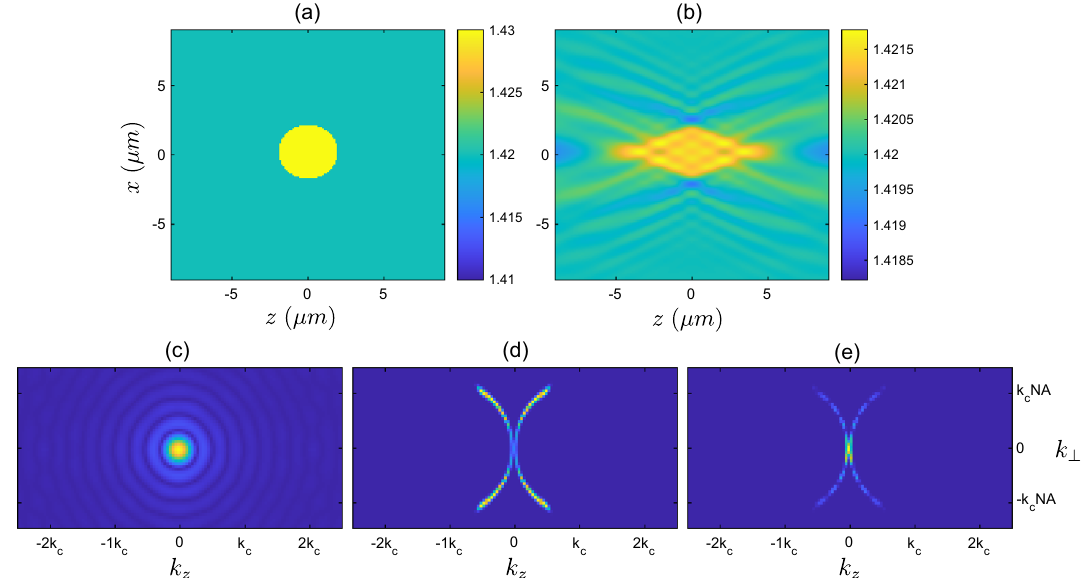
Figure 7. ( a ) Refractive index corresponding to the scattering potential of the low contrast cylinder F 2 . ( b ) Refractive index corresponding to the linear reconstruction F linrec 2 when measuring using the forward plane, f (cid:31) . ( c ) Magnitude of Fourier transform, |˜ F true 2 ( k ) , of the true low contrast disk sample. ( d ) Theoretical k -space f | ( k ) for the forward measurement plane. ( e ) Magnitude of Fourier transform of true sample after being filter, f � f ( k ) f � filtered |˜ F true 5 ( k ) , i.e. ( c ) multiplied by ( d ). f × |